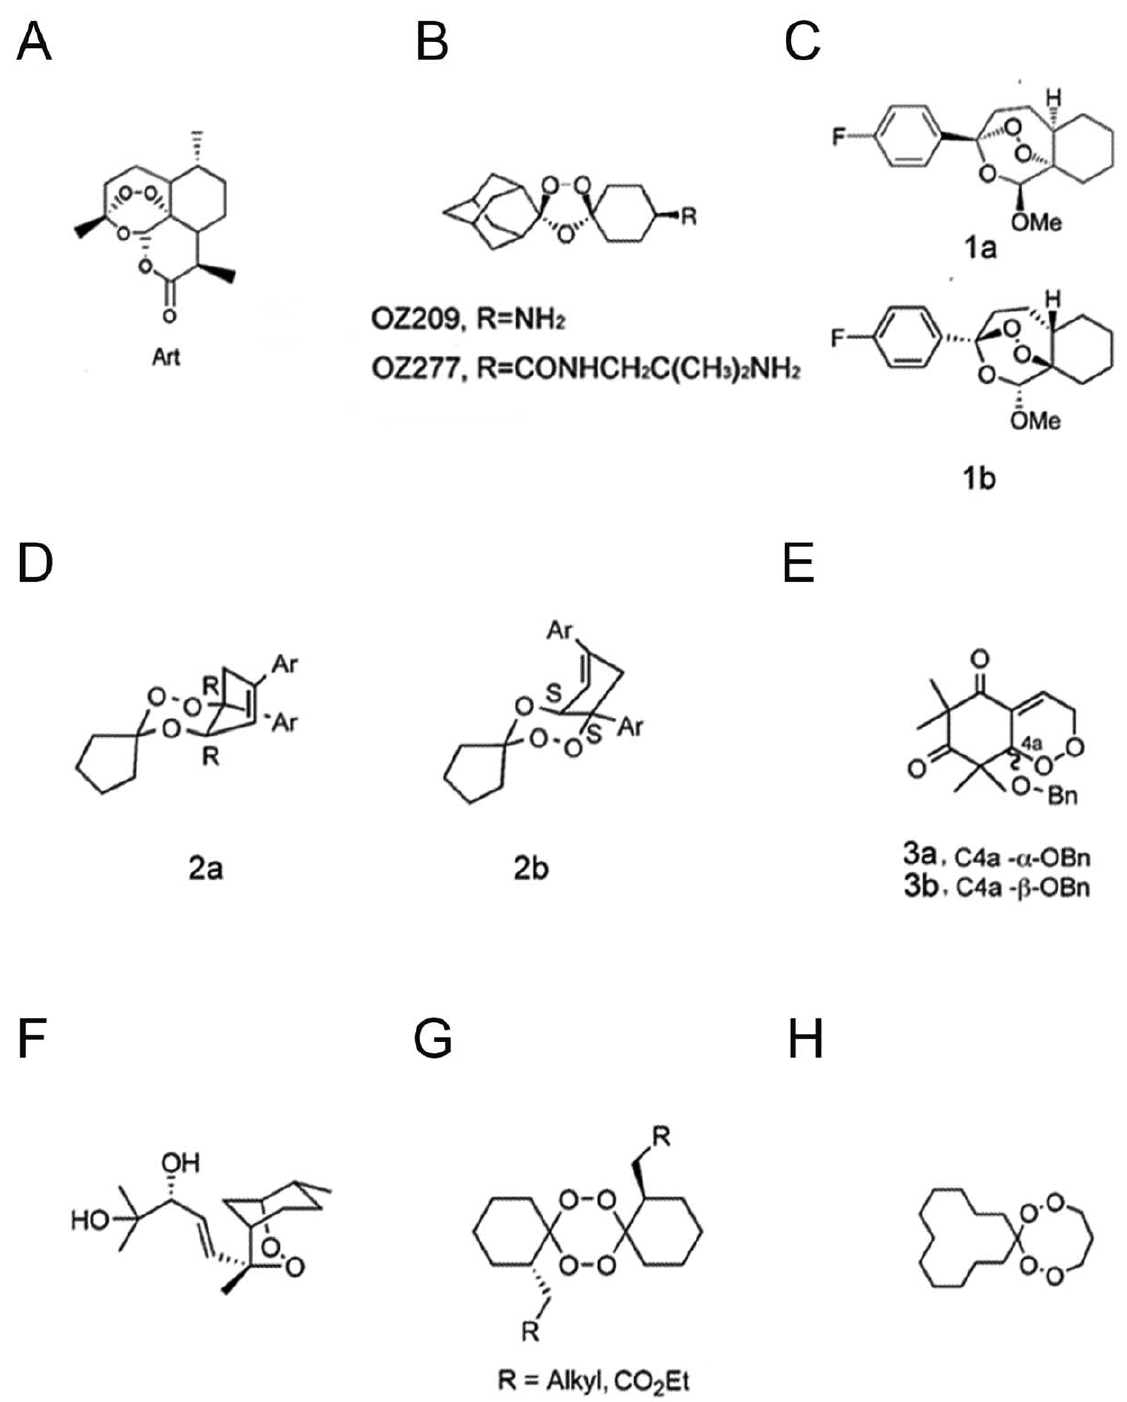
Yingzhaosu A. (G and H) Antimalarial tetraoxanes.